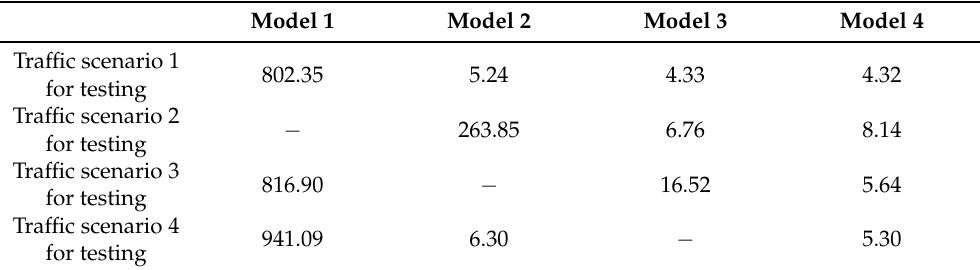
Table 10. Average delay of the four models for each test traffic